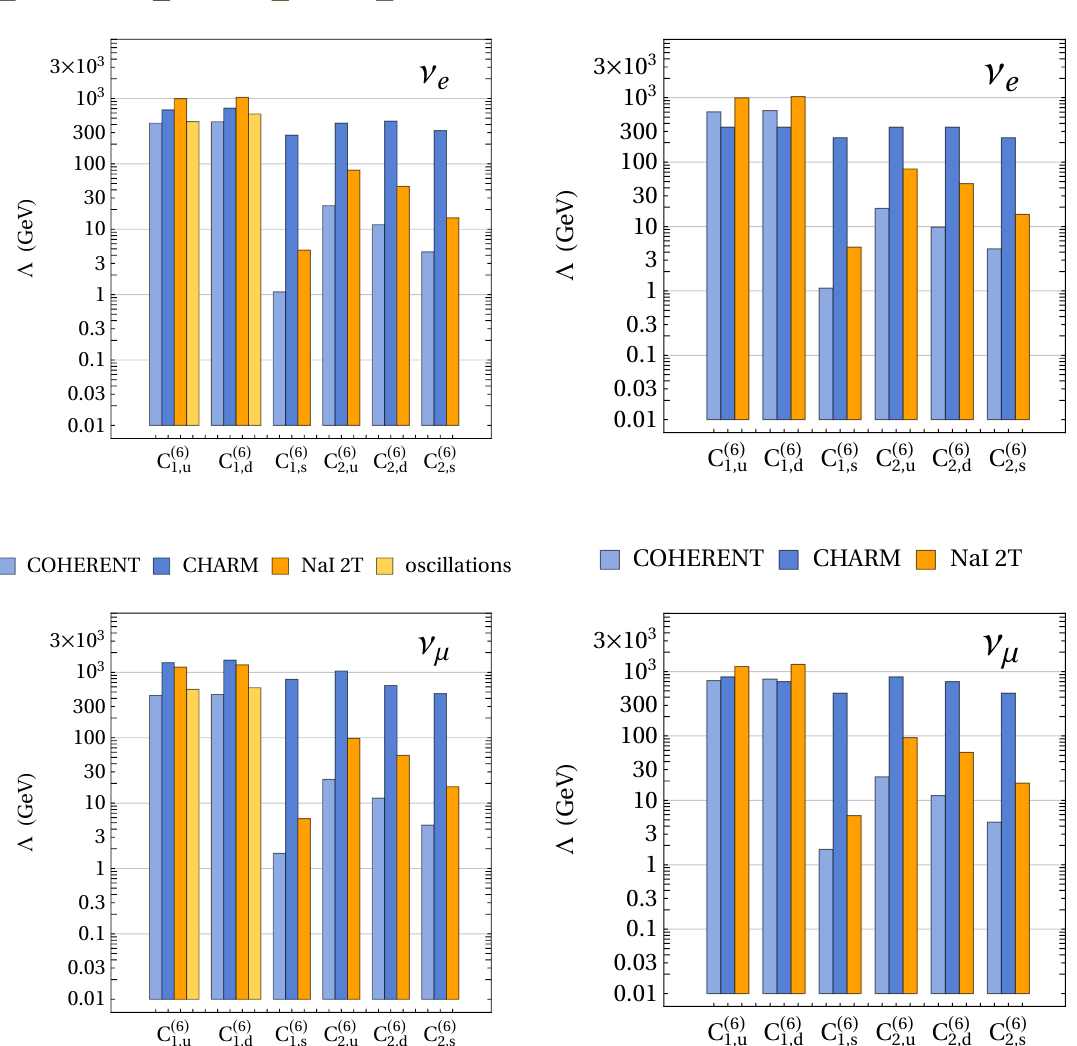
Figure 7 . Limits from COHERENT, CHARM, neutrino oscillations and projected limits from a NaI 2T experiment on the scale Λ of dimension 6 operators for electron neutrinos (top) and muon neutrinos (bottom). The two panels on the left correspond to lepton flavor conserving operators ( ν i → ν i ), the ones on the right to lepton flavor violating operators ( ν i → ν j , i 6 = j